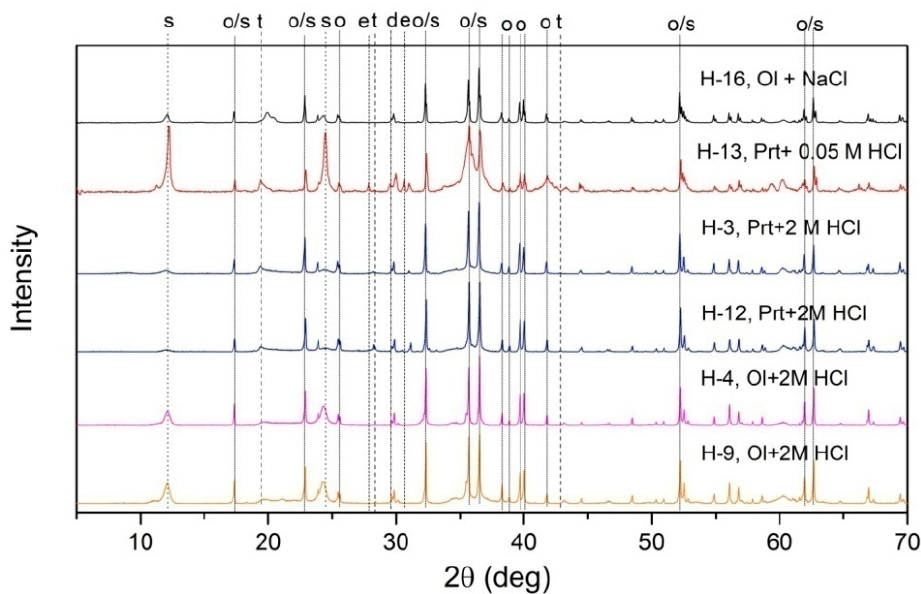
Figure 1. X-ray di ff raction (XRD) patterns of the experimental products after serpentinization of olivine Figure 1. X-ray diffraction (XRD) patterns of the experimental products after serpentinization of and peridotite. o: olivine; e: enstatite; d: diopside; s: serpentine; t: olivine and peridotite. o: olivine; e: enstatite; d: diopside; s: serpentine; t: talc.